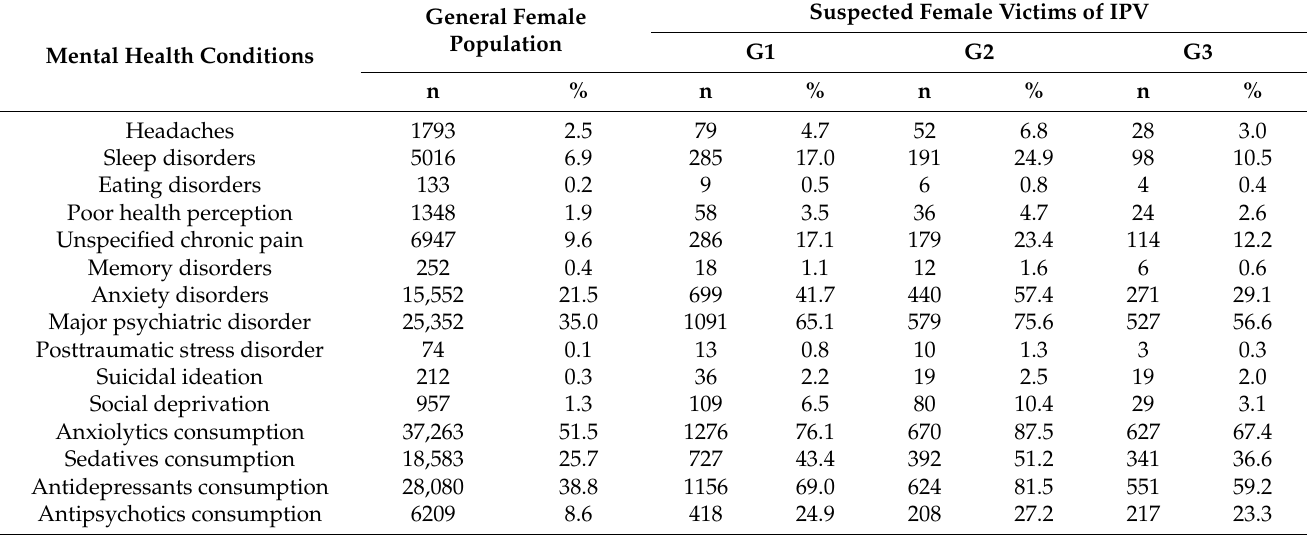
Table 4. Victims’ mental health conditions.